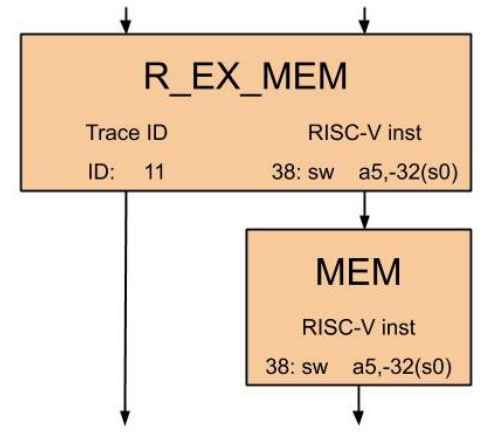
Figure 6. Trace’s instruction pair memory stage.